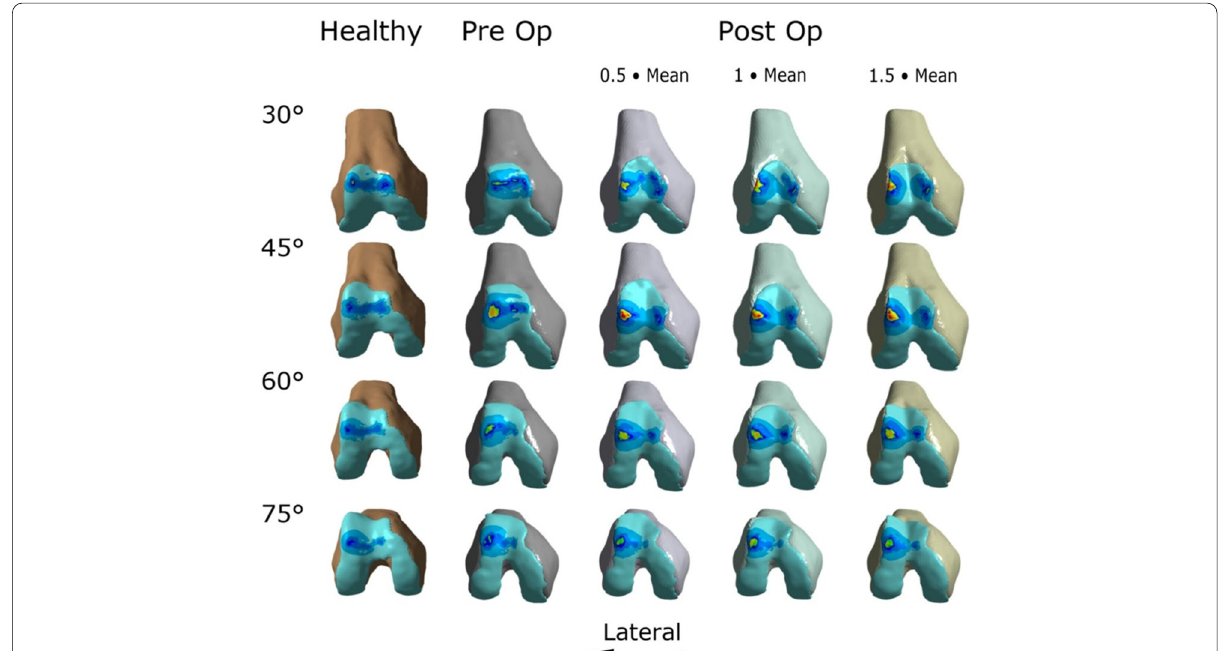
Fig. 5 Contact pressure patterns are superimposed over the trochlea for the healthy control knee and the trochleodysplastic knee pre- and postoperatively at 30°, 45°, 60° and 75° of flexion. The pressure scale is constant for all models. The color assignment is nonlinear to maximize color distribution. As the healthy model represents a left knee, the respective images have been flipped to facilitate comparison. Note the pressure peaks on the lateral trochlea, which is pronounced at 30 to 60° flexion as well as the additional pressure peak at 30 degree flexion on the medial trochlea. We believe that these are evoked by the articular incongruity at the site of the greatest bony correction